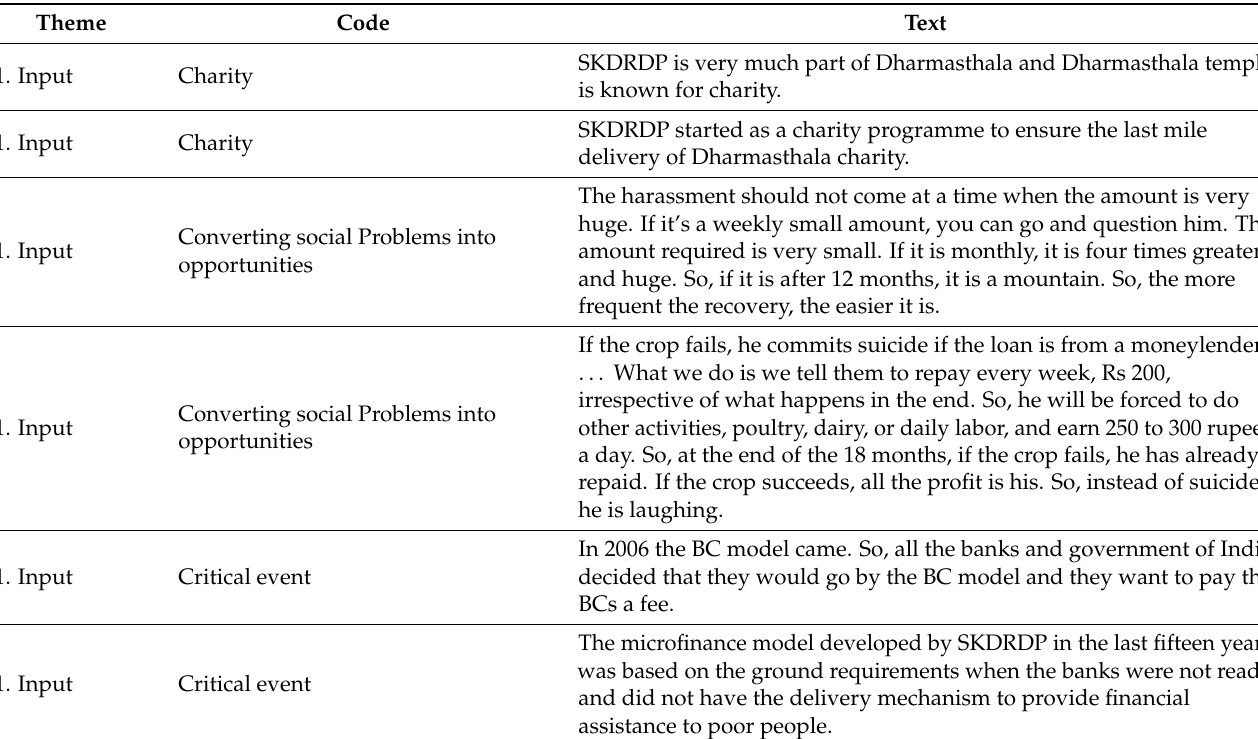
Table 2. Two examples of text of each of 11 codes (other than